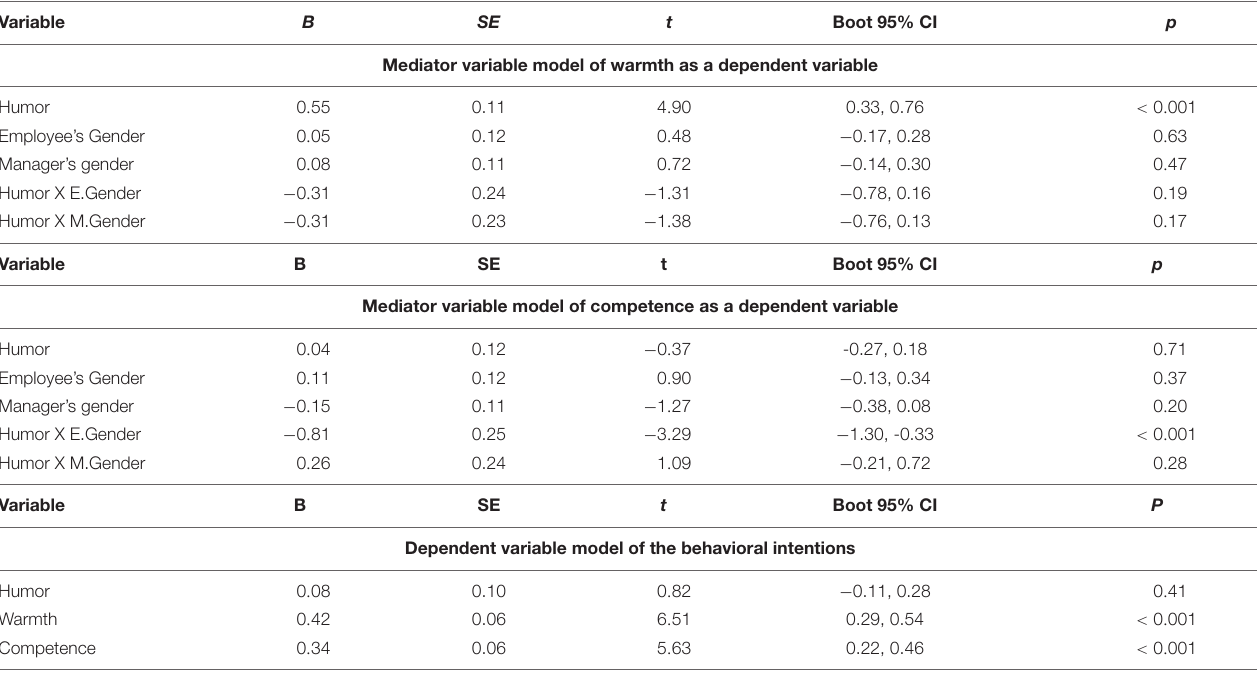
TABLE 3 | Moderation and mediation effects for humor.